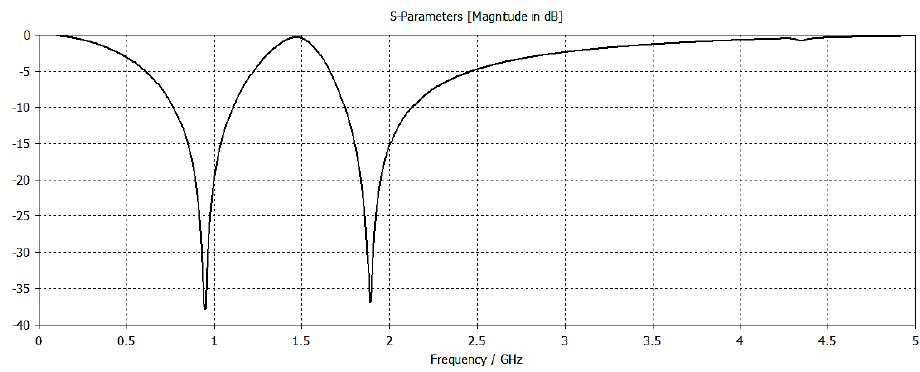
Figure 19. The S 21 chart for SRRs unit